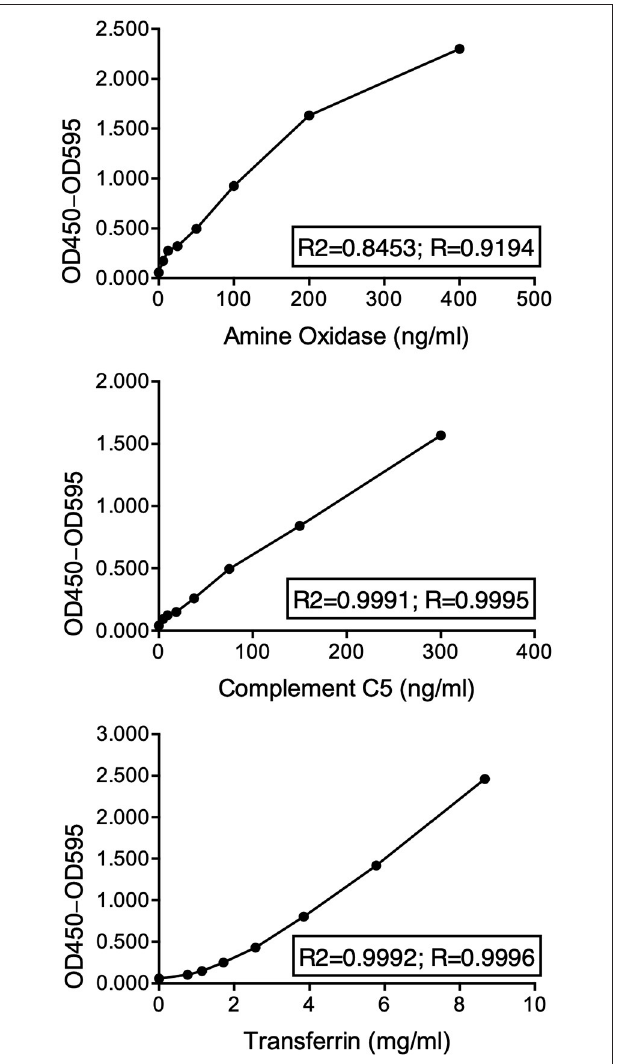
FIGURE 3 | Nonlinear regression of OD and concentration of amine oxidase, complement component 5, and transferrin confirmed precision of each in-house sandwich ELISA in their linear range. Triplicates of eight serially diluted concentrations of each purified protein were quantified by their respective in-house sandwich ELISAs. ODs (OD 450nm – OD 595nm) vs. concentrations were modeled by a sigmoidal, four-parameter logistic (4PL) fit regression, and the coefficient of determination ( R 2 ) and the coefficient of correlation ( R ) were estimated.